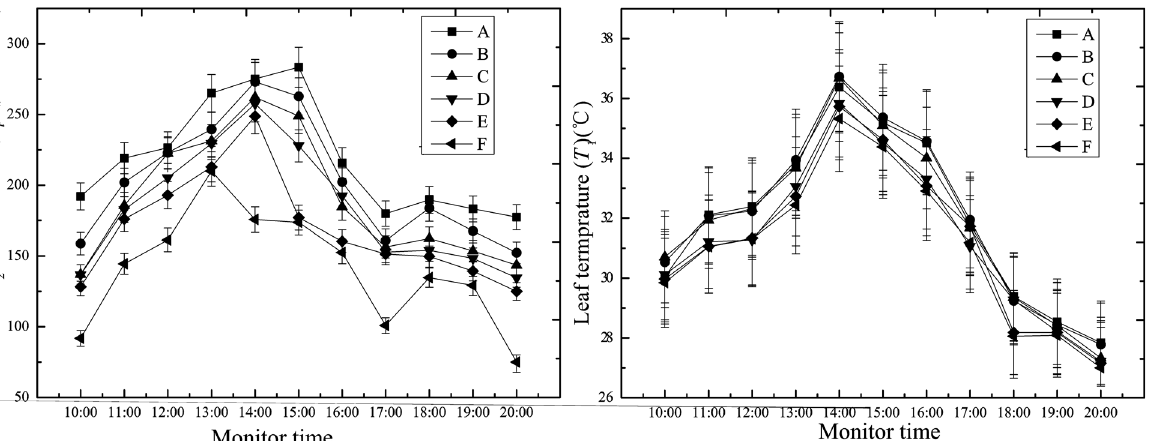
Fig 10. Effect of different salt dust treatments on the intercellular CO 2 concentration ( C i ) and temperature ( T l ) of the cotton leaves.